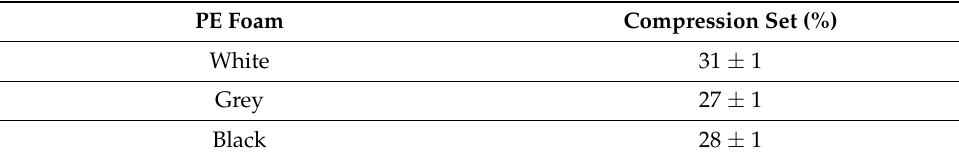
Table 2. Compression set of PE foams.